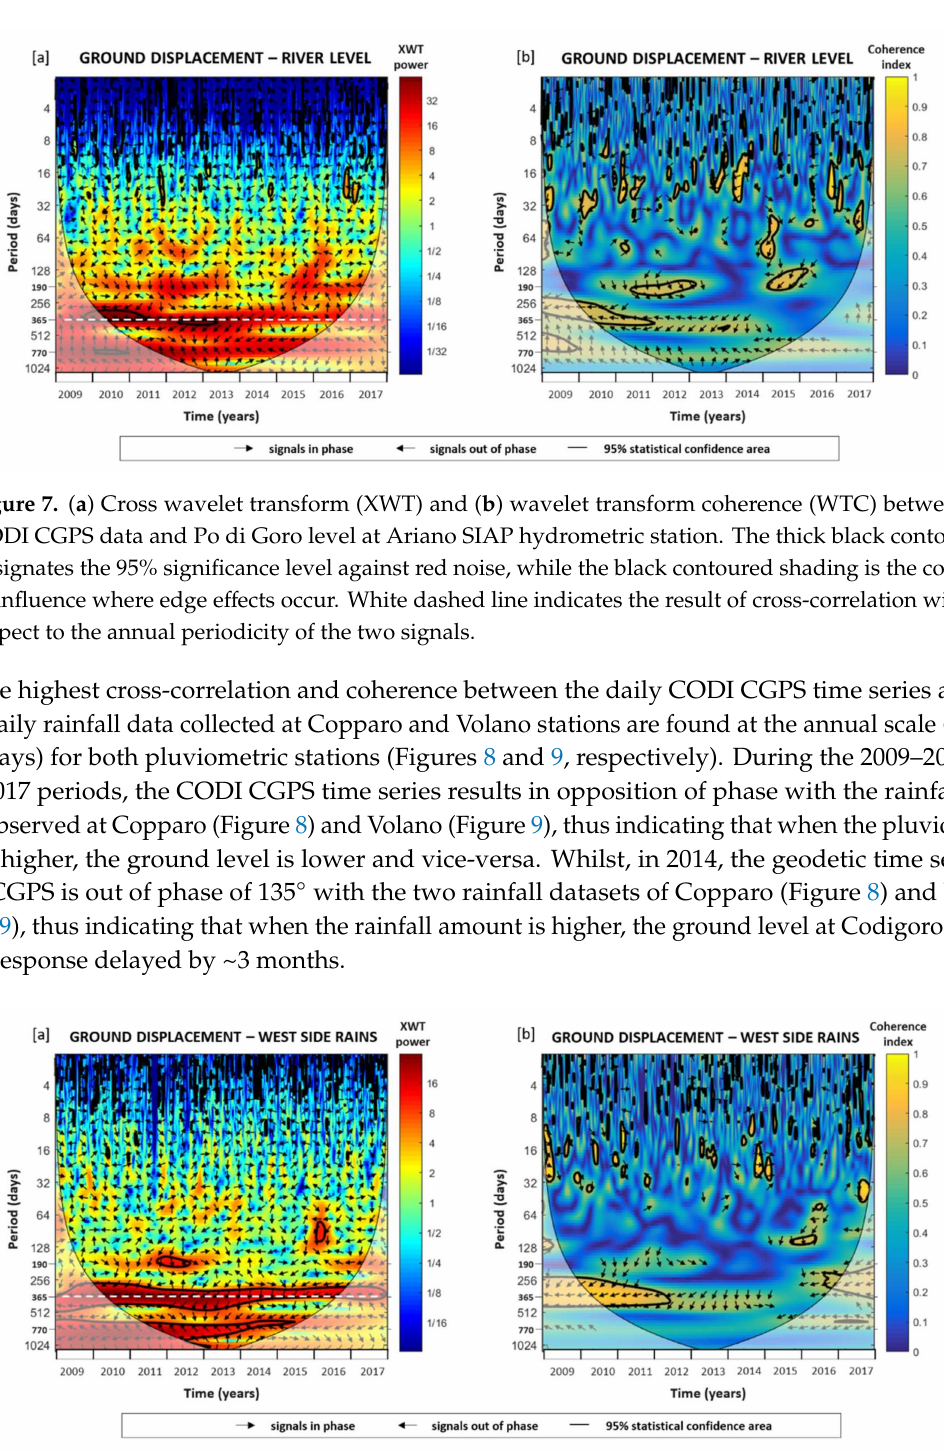
Figure 8. ( a ) Cross wavelet transform (XWT) and ( b ) wavelet transform coherence (WTC) between CODI CGPS data and rainfall data at Copparo station. The thick black contour designates the 95% significance level against red noise, while the black contoured shading is the cone of influence where edge e ff ects occur. White dashed line indicates the result of cross-correlation with respect to the annual periodicity of the two